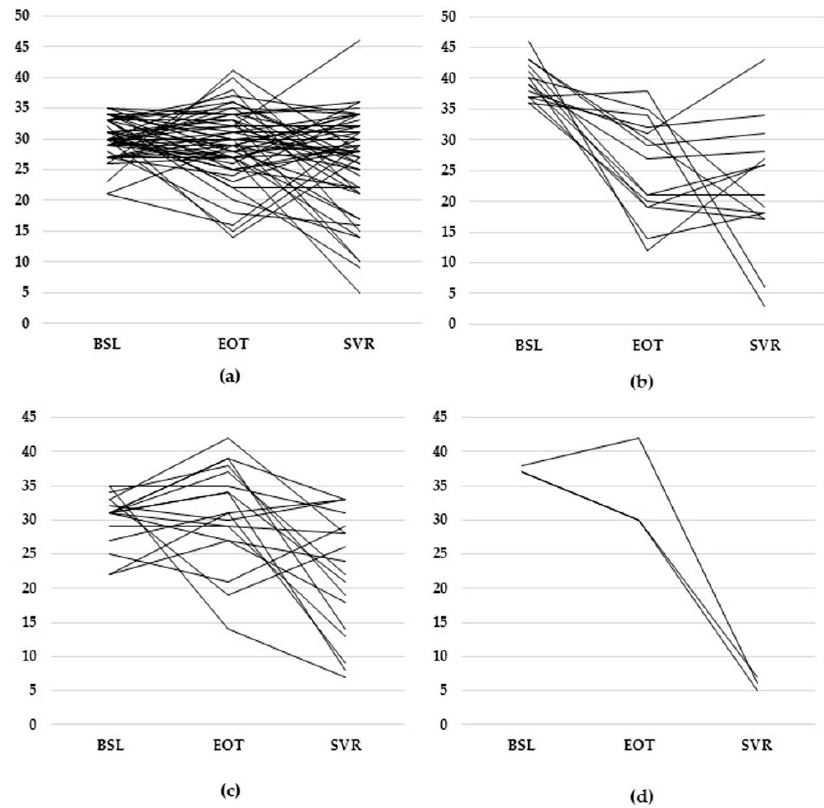
Figure 2. Evolution of individual PSS scores at BSL, EOT, and SVR: ( a ) female subjects with moderate stress levels at the beginning of the study, ( b ) female subjects with high stress levels at the beginning of the study, ( c ) male subjects with moderate stress levels at the beginning of the study, ( d ) male subjects with moderate stress levels at the beginning of the study (only one subject, a woman, had a low level of stress at BSL).